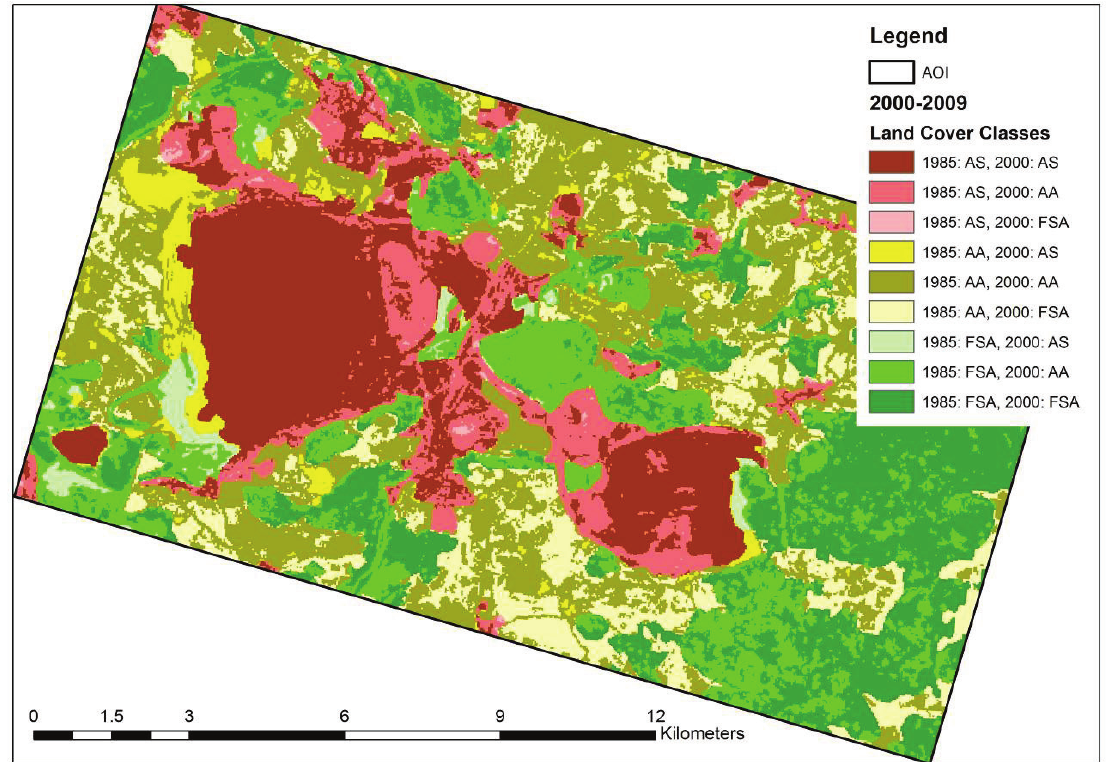
Figure 7. Land-cover changes in the AOI as a result of large-scale mining from 2000 to